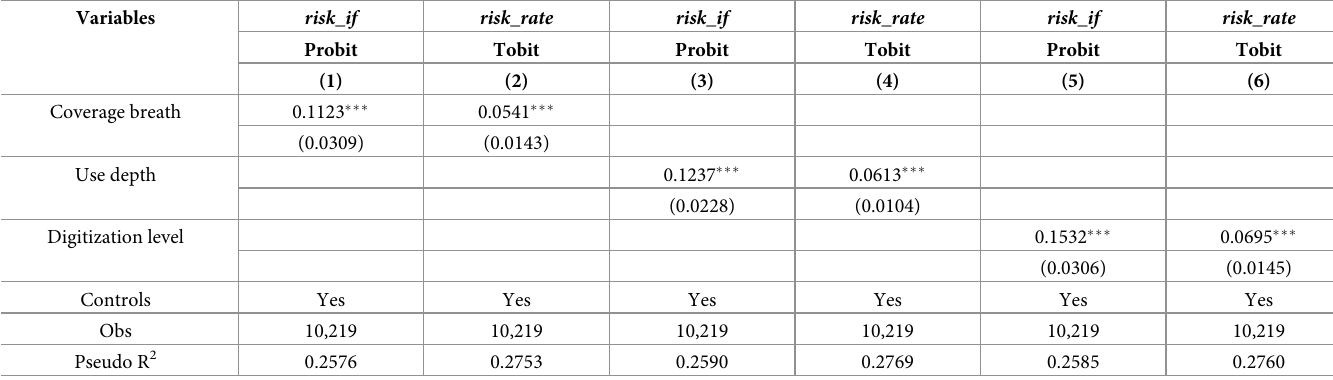
Table 3. The regression of the first-level indicators on household participation in risky financial